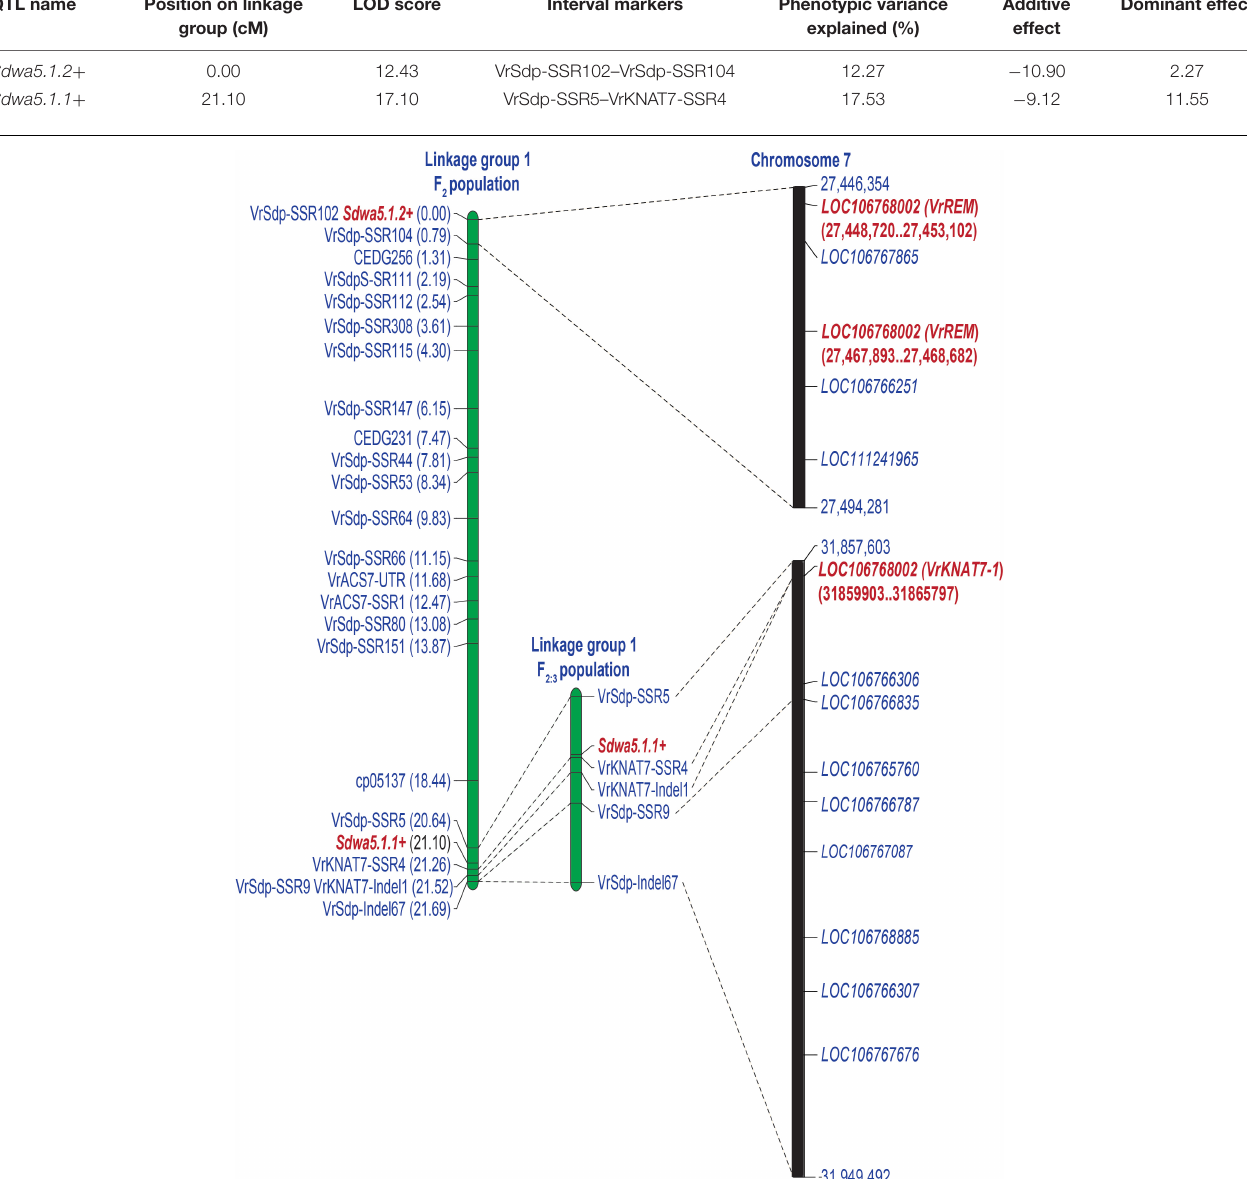
Frontiers in Plant Science |